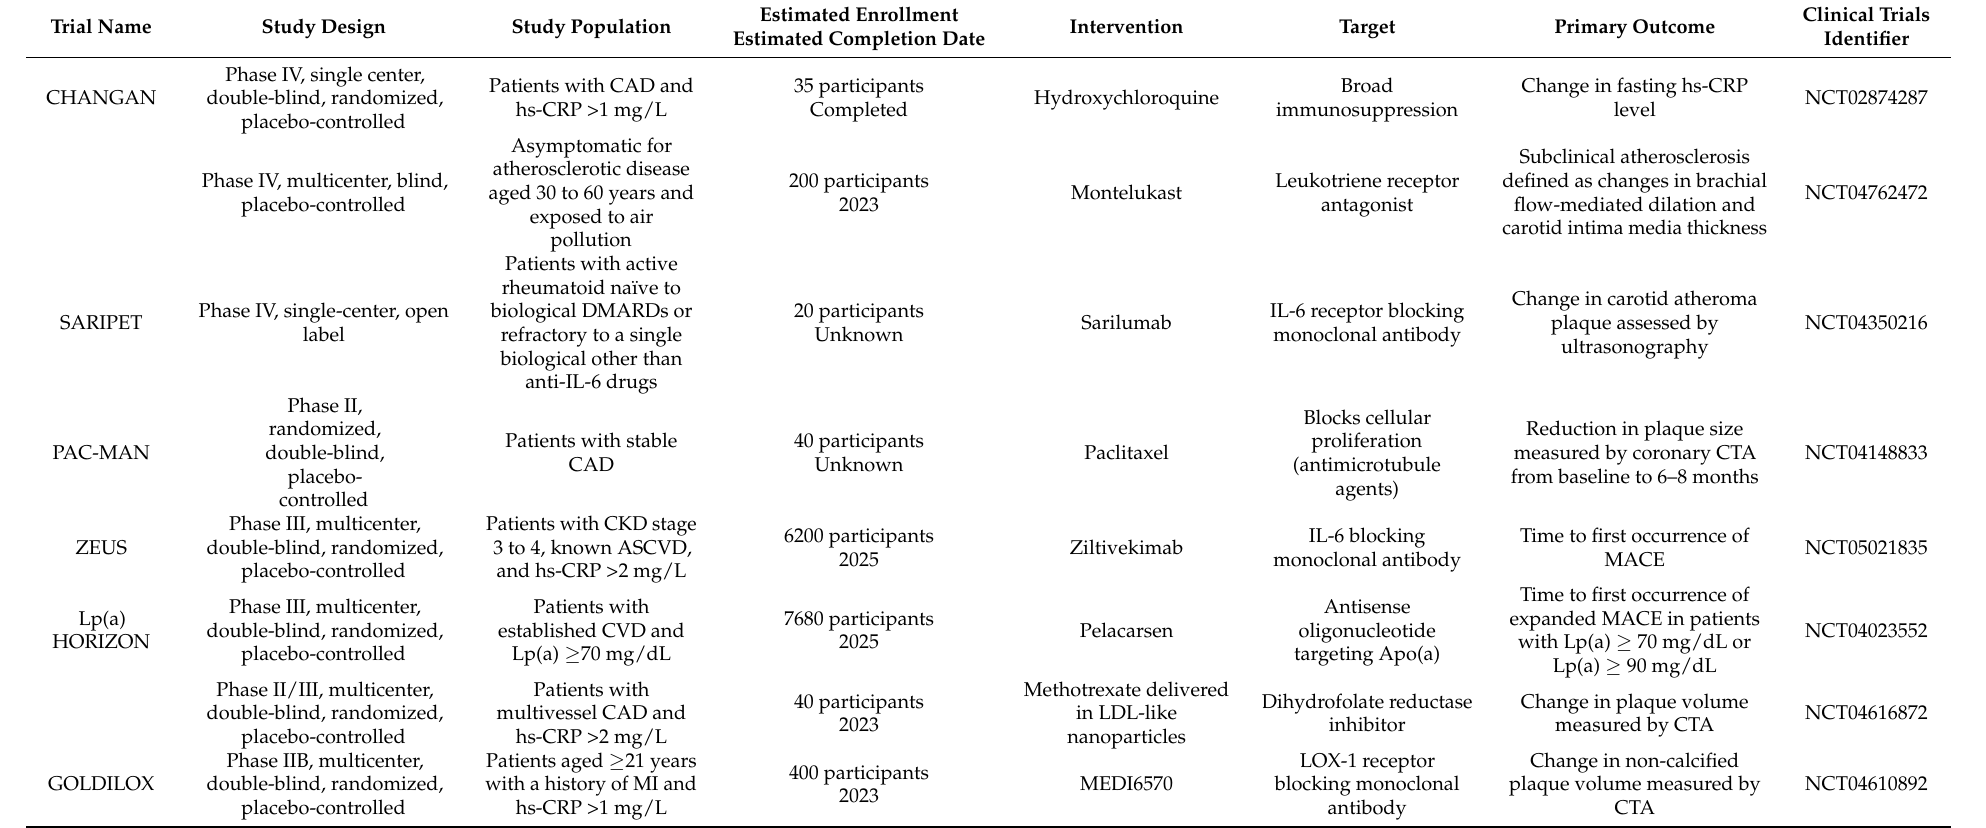
Table 1. Ongoing clinical studies of treatments targeting inflammation in the context of